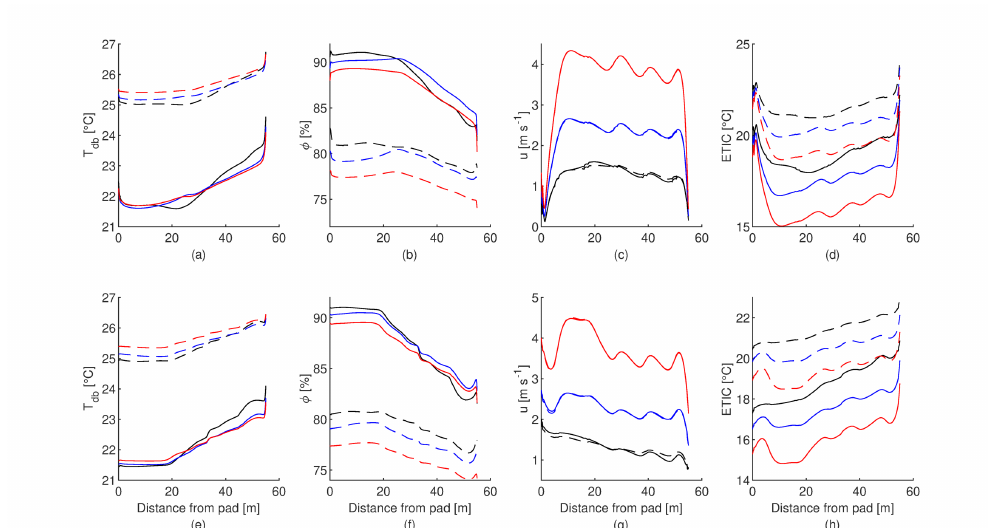
Figure 12. Profile of variation of the dry-bulb temperature ( T db ), relative humidity ( φ ), Equivalent Temperature Index for dairy Cattle (ETIC) and air velocity ( u ) along the centre of the tunnel-ventilated compost-packed bedded dairy barn. At 0.2 m ( a – d ) and 1 m ( e – h ) above the compost bedded, for two environmental conditions for dry-bulb temperature-relative humidity of 24 ◦ C—75% (solid line) and 30 ◦ C—55% (dashed line), and three airflow velocities across the exhaust fans: 1.5 m s − 1 (black line), 3 m s − 1 (blue line) and 5 m s − 1 (red